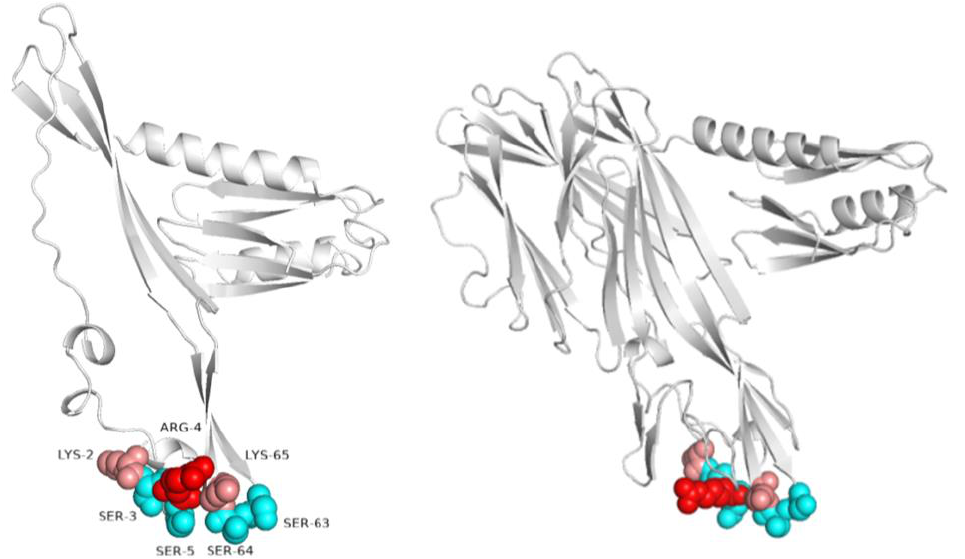
Figure 5. Proposed site of HlyIILCTD binding to erythrocyte-surface glycosaminoglycans. On the left, the HlyIILCTD structure predicted by AlphaFold [20,21] for a putative protein from B. thuringiensis ser. israelensis ATCC 35646 Uniprot: Q3EPX6. On the right, the structure of the full-length HlyII toxin from B. cereus ATCC 14579 Uniprot: Q81AN8, predicted by AlphaFold [20,21]. The putative GAG-binding site is highlighted in color. Positively charged amino acids lysine and arginine are shown in red and salmon color; serines are highlighted in cyan.